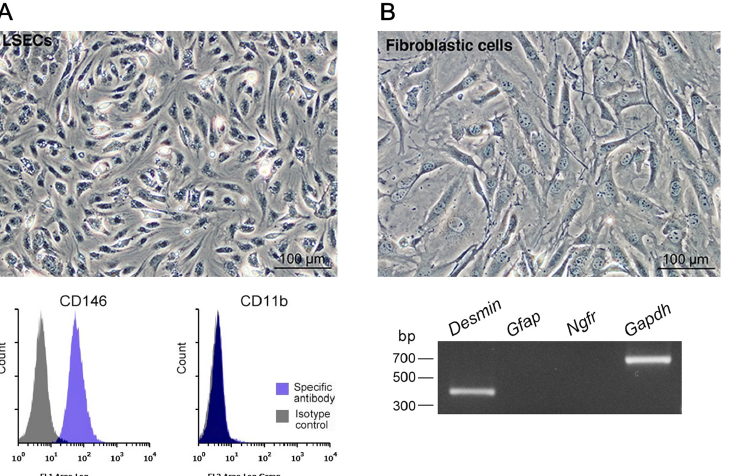
Figure 3. Phase-contrast images and expressions of specific markers in LSECs and fibroblastic cells propagated using mixed culture with liver Mø. ( A ) Representative phase-contrast image of primary LSECs showing small epithelial cell morphologies, and representative histograms showing CD146 and CD11b expression using flow cytometry (blue histogram, specific antibody; gray histogram, isotype control). CD146 is a specific marker of LSECs. ( B ) A representative phase-contrast image showing fibroblastic cell morphology and expression profile of hepatic stellate cell markers using RT-PCR in fibroblastic cell propagated using mixed culture with Mø from the liver.